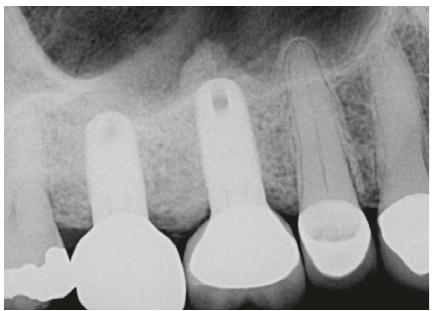
Figure 21: Radiograph at 13 months postoperatively presented increased bone density around the implant apex.